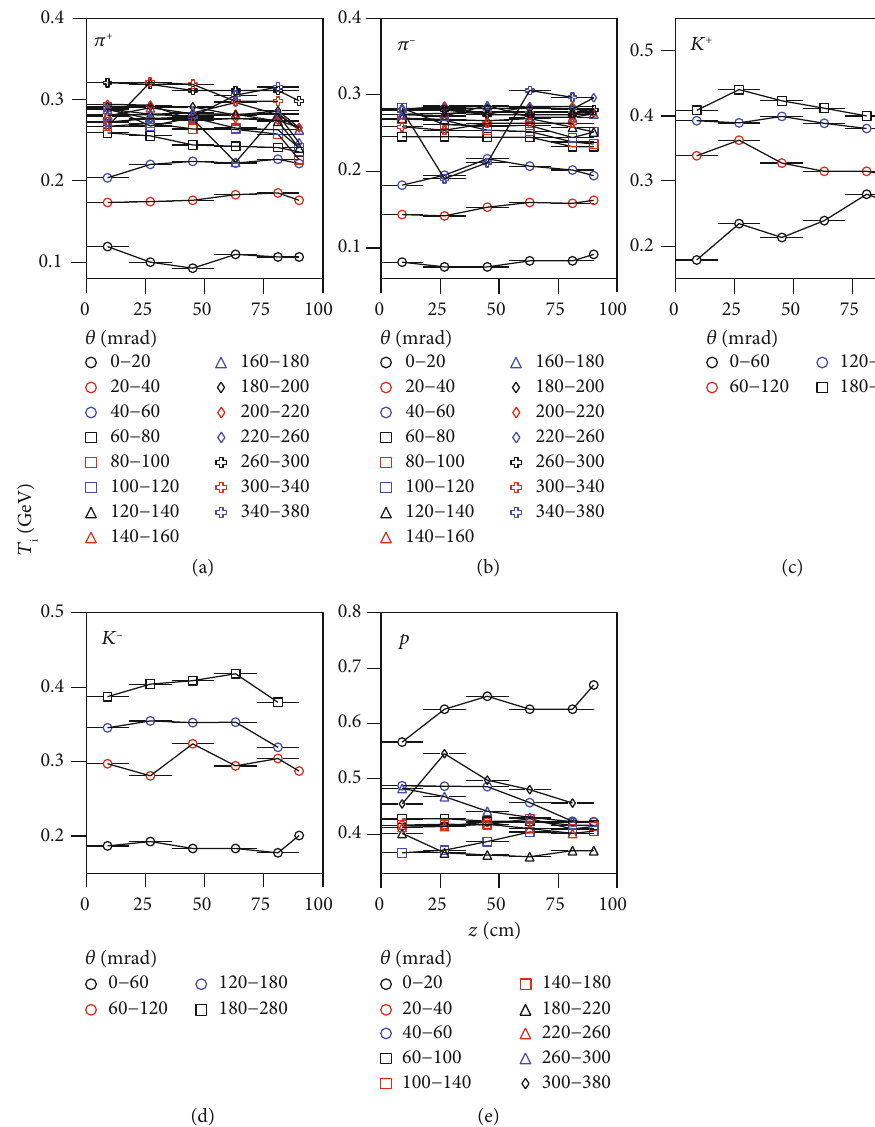
Figure 15: Same as Figure 14 but showing the dependence of T